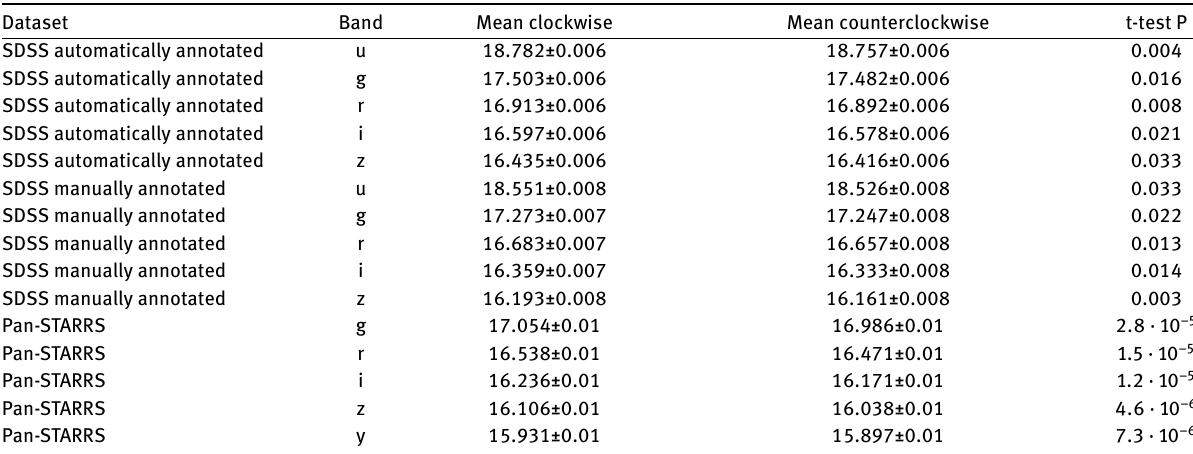
Table 7. Exponential magnitude mean, standard error, and t-test of the difference between clockwise and counterclockwise galaxies in the (120 ∘ , 210 ∘ ) RA range (Shamir 2017b).